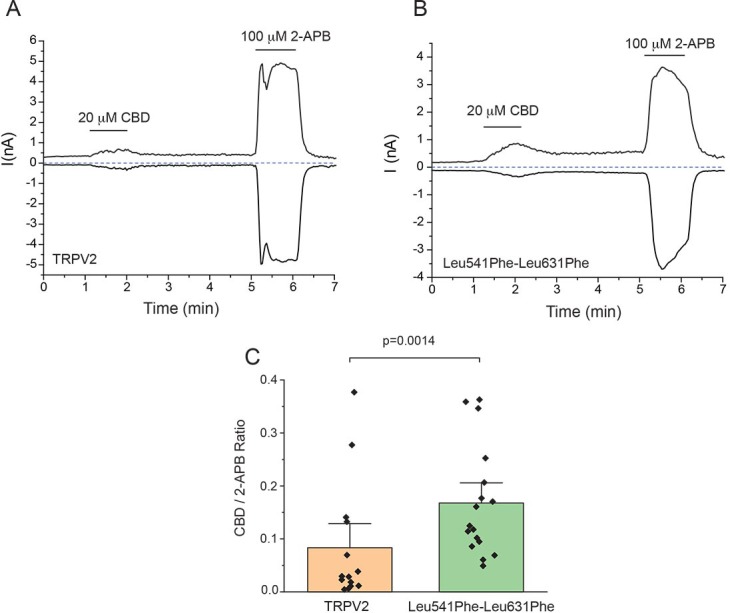
The double mutant L541F-L631F increases current responses to CBD.Whole cell patch clamp experiments in HEK293T cells were performed as described in the Materials and methods section. Representative current traces in response to 20 μM CBD and 100 μM 2-APB at 100 mV (upward deflections) and at −100 mV (downward deflections) in cells transfected with (A) wild type TRPV2 and with (B) Leu541Phe-Leu631Phe mutant. (C) Summary of the ratio of currents induced by CBD and 2-APB. Statistical significance was determined by the non-parametric Kolmogorov Smirnov test.